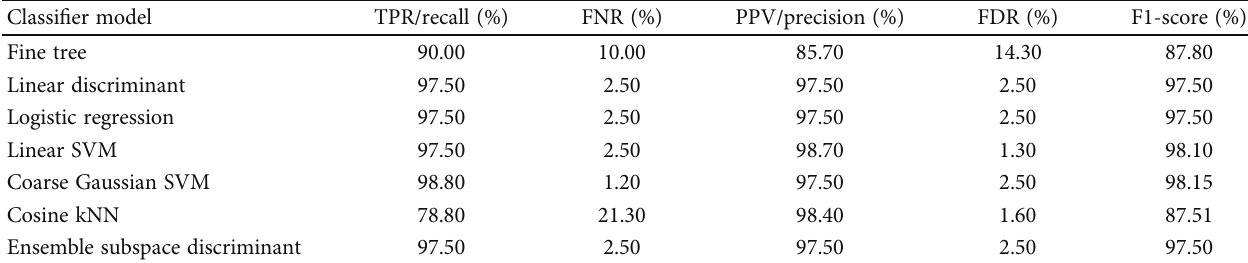
Table 4: The classi fi cation performance for COVID-19 with SURF features.